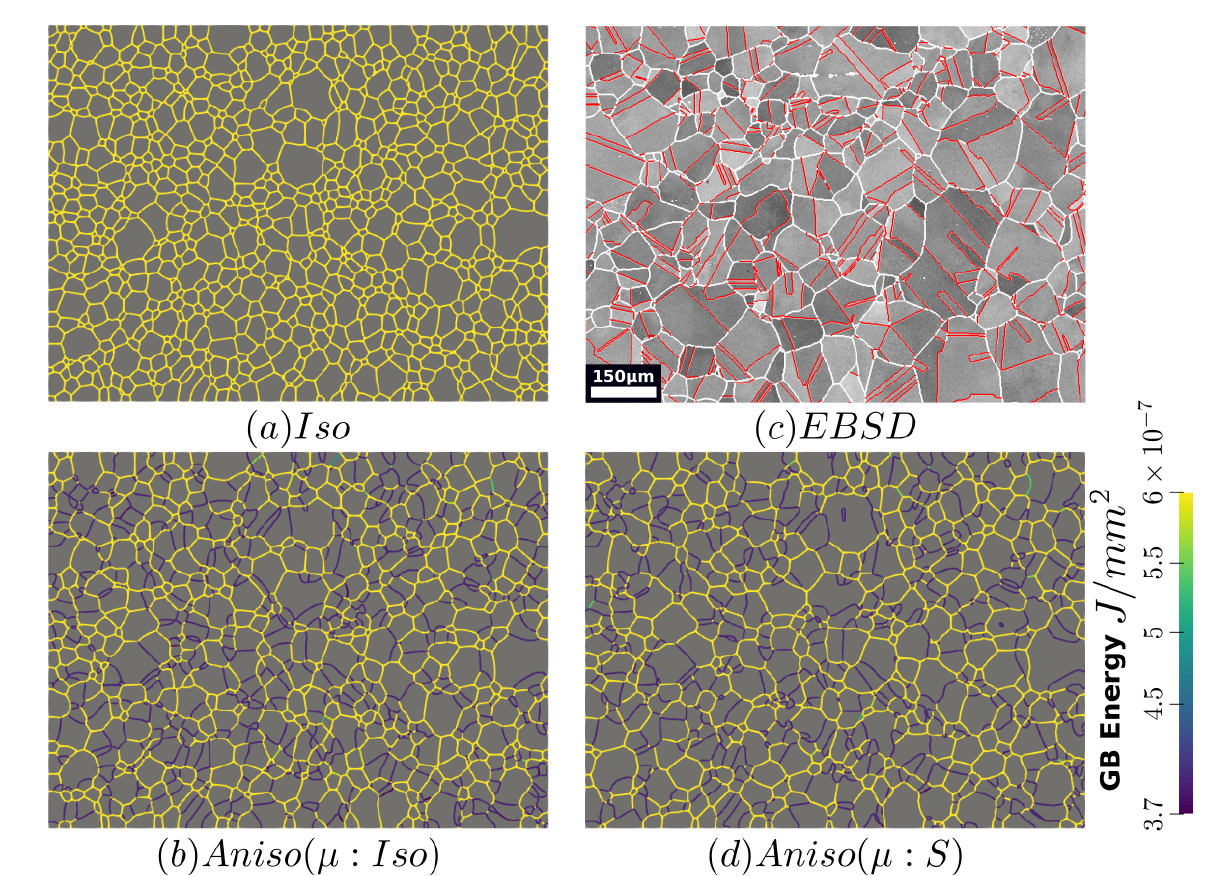
Figure 22. GB energy of the microstructures obtained numerically using the ( a ) isotropic formulation and the anisotropic formulations with ( b ) isotropic and ( d ) heterogeneous GB mobility. ( c ) illustrates the corresponding experimental band contrast map at t = 2 h.